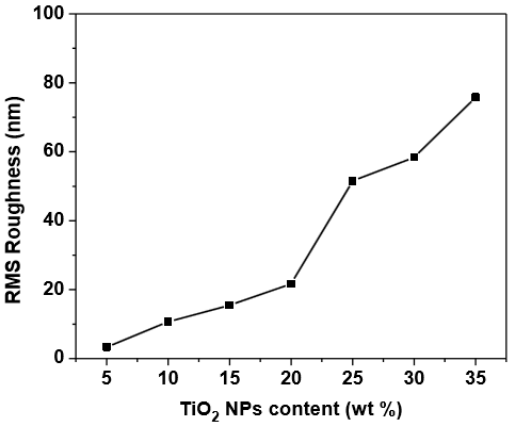
Figure 7. Root mean square (RMS) roughness for PFO/0.5 wt % Fluorol 7GA/TiO 2 films as a function of TiO 2 NP content.